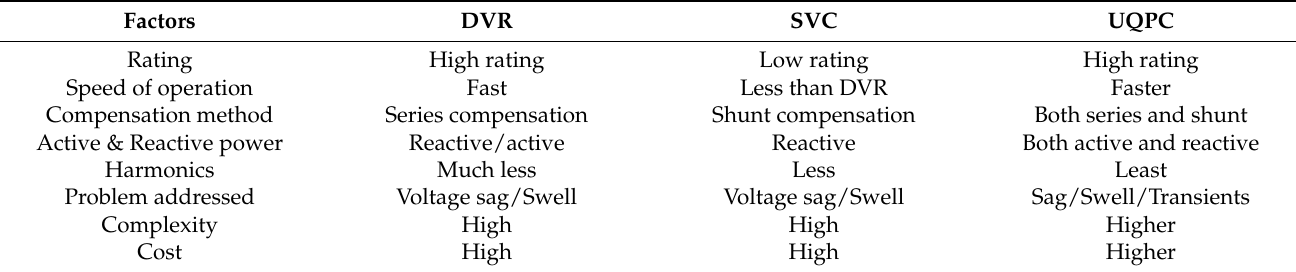
Table 2. Comparison of various technologies used for voltage sag